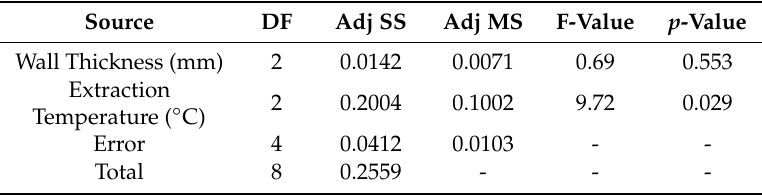
Table 14. ANOVA for grey relational grade.